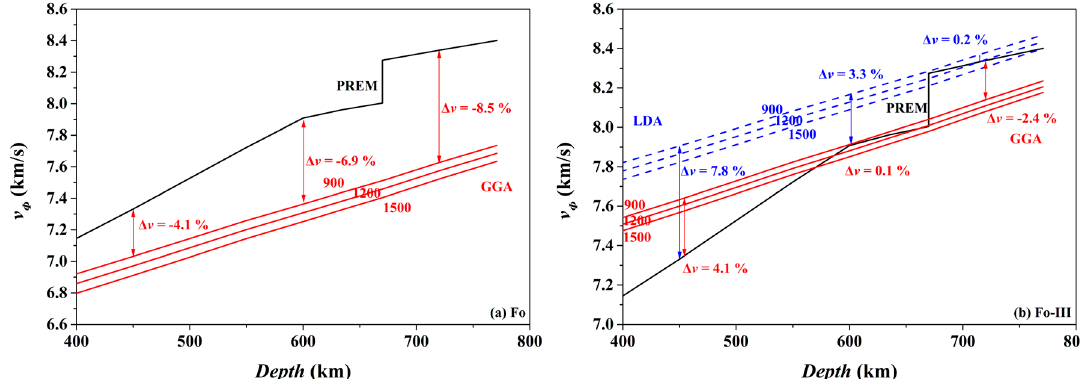
Figure 16. Calculated bulk sound velocity ( v Φ )-depth profiles at 900, 1200 and 1500 K for Fo ( a ); and Fo-III ( b ). As a reference, the PREM bulk sound velocity model [98] is also sketched. The shown bulk sound velocity ( v Φ ) at 450 km depth, 600 km depth or 720 km depth and 900 K is calculated as Δ v Φ = 100 × ( v Φ -Fo − v Φ -PREM )/ v Φ -PREM , where v Φ -Fo stands for v Φ -Fo in ( a ), and v Φ -Fo-III in ( b ). The GGA results at different T are shown as red lines while the LDA results as blue lines. For the purpose of illustration, the bulk sound velocity differences at certain depth obtained by the GGA method and the LDA method are slightly horizontally shifted.